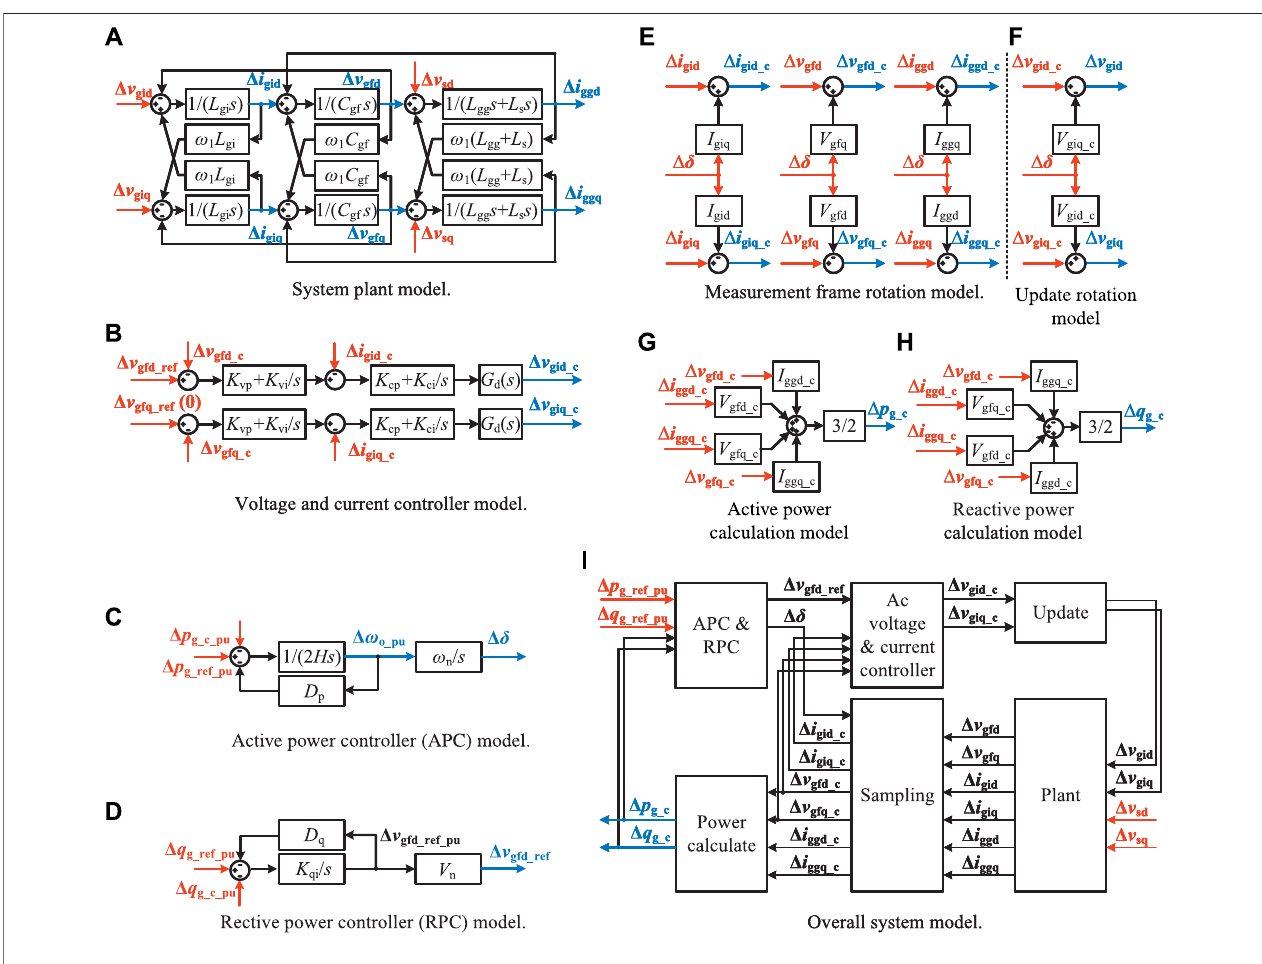
FIGURE 2 | Small-signal model of grid-forming